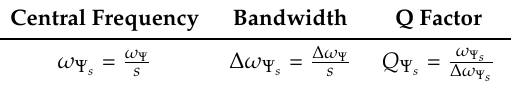
Table 1. Wavelets band-pass behavior